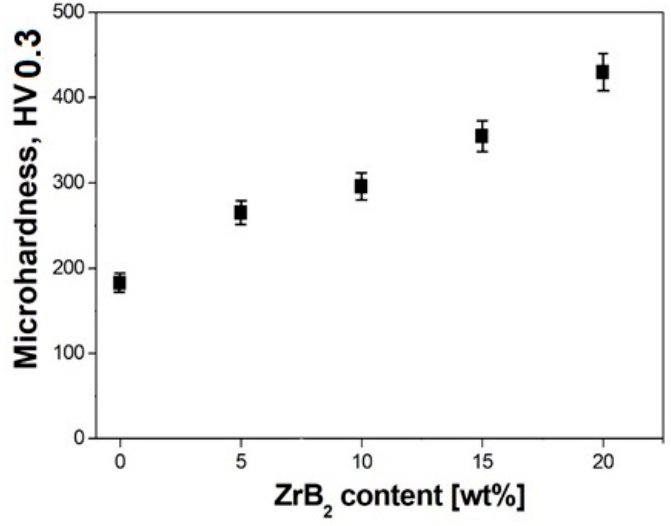
Figure 10. Effect of ZrB 2 content on microhardness.